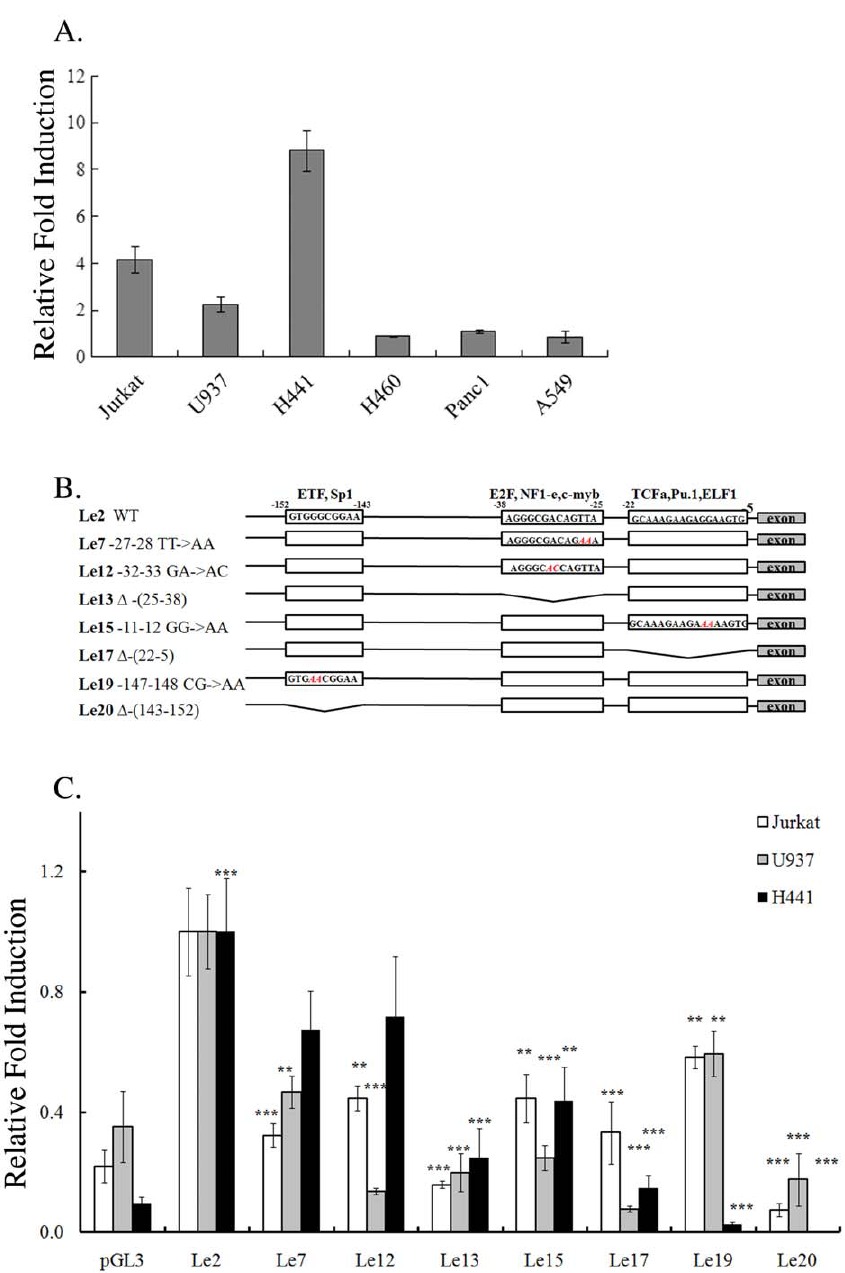
Figure 2. The vav 1 5 9 untranscribed sequences contain cell-type specific cis-regulatory elements. (A) Expression of wild-type (wt) luciferase reporter gene (Le2) in cell lines from various tissue origins. Le2 was transfected into the cell lines as described in Materials and Methods and luciferase activity was measured 24 hr later. Data show luciferase activity normalized to Renilla transfection efficiency control and calculated relative to the luciferase activity of an empty vector expression, pGL3. The experiments were repeated five times. (B) Schematic map of the 5 9 regulatory region of the human vav 1 gene. Three putative transcription factor binding sites are highlighted by boxes. The changes introduced in these regions are as follows: nucleotide substitutions (red) and deletions (crooked lines). (C) The effect of these mutations/deletions was analyzed in Jurkat T cells, U937 myeloid cells and H441 lung cancer cells. Following transfection with plasmids containing luciferase under wt (Le2) or mutated vav 1 promoter, the luciferase activity was measured and fold induction of activity was calculated relative to the activity of Le2. Experiments were repeated five times. Statistics were performed using the unpaired student T test. (**) indicates p , 0.05 value and (***) indicates p , 0.01. doi:10.1371/journal.pone.0029939.g002 HpaII fails to digest the methylated plasmid but does digest the and about 50% lower in U937 cells. These results indicate that methylation of the vav 1 promoter is important for its restricted unmethylated plasmid (Fig. 6A). The unmethylated form of Le2 tissue specific expression. transfected into Jurkat, U937 and H441 cells led to expression of the reporter gene (Fig. 6B), similar to the results presented in The CpG content in vav 1 regulatory sequences is not high Fig. 2A. In contrast, luciferase activity was more than 90% lower enough to create CpG islands. We hypothesized that methylation in Jurkat and H441 cells transfected with the methylated plasmid of individual CpG sites may interfere with transcription by a